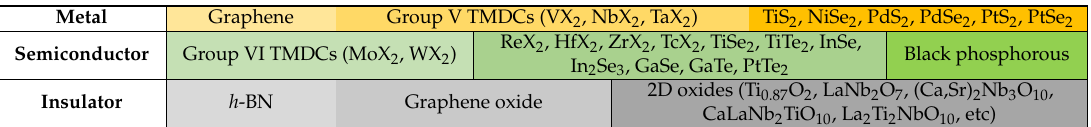
Table 1. A variety of 2D materials with different electrical